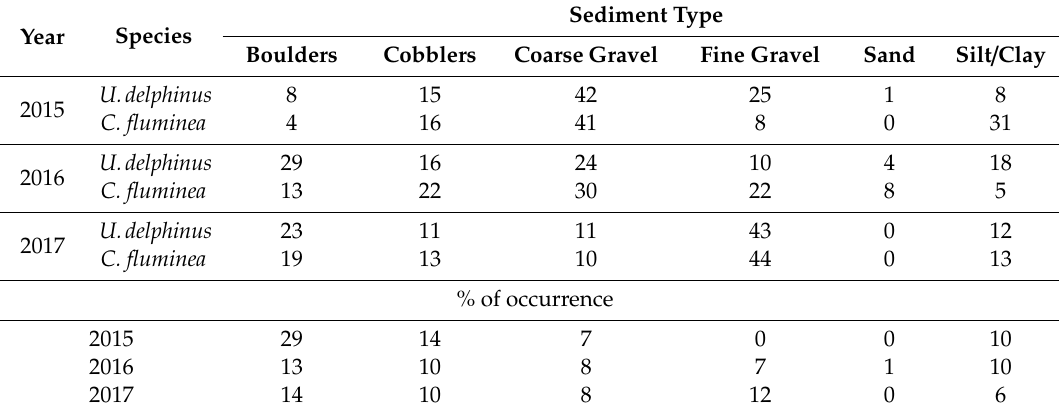
Table A1. Percentage of occurrence of U. delphinus and C. fluminea in sediment types and percentage of occurrence of each sediment type